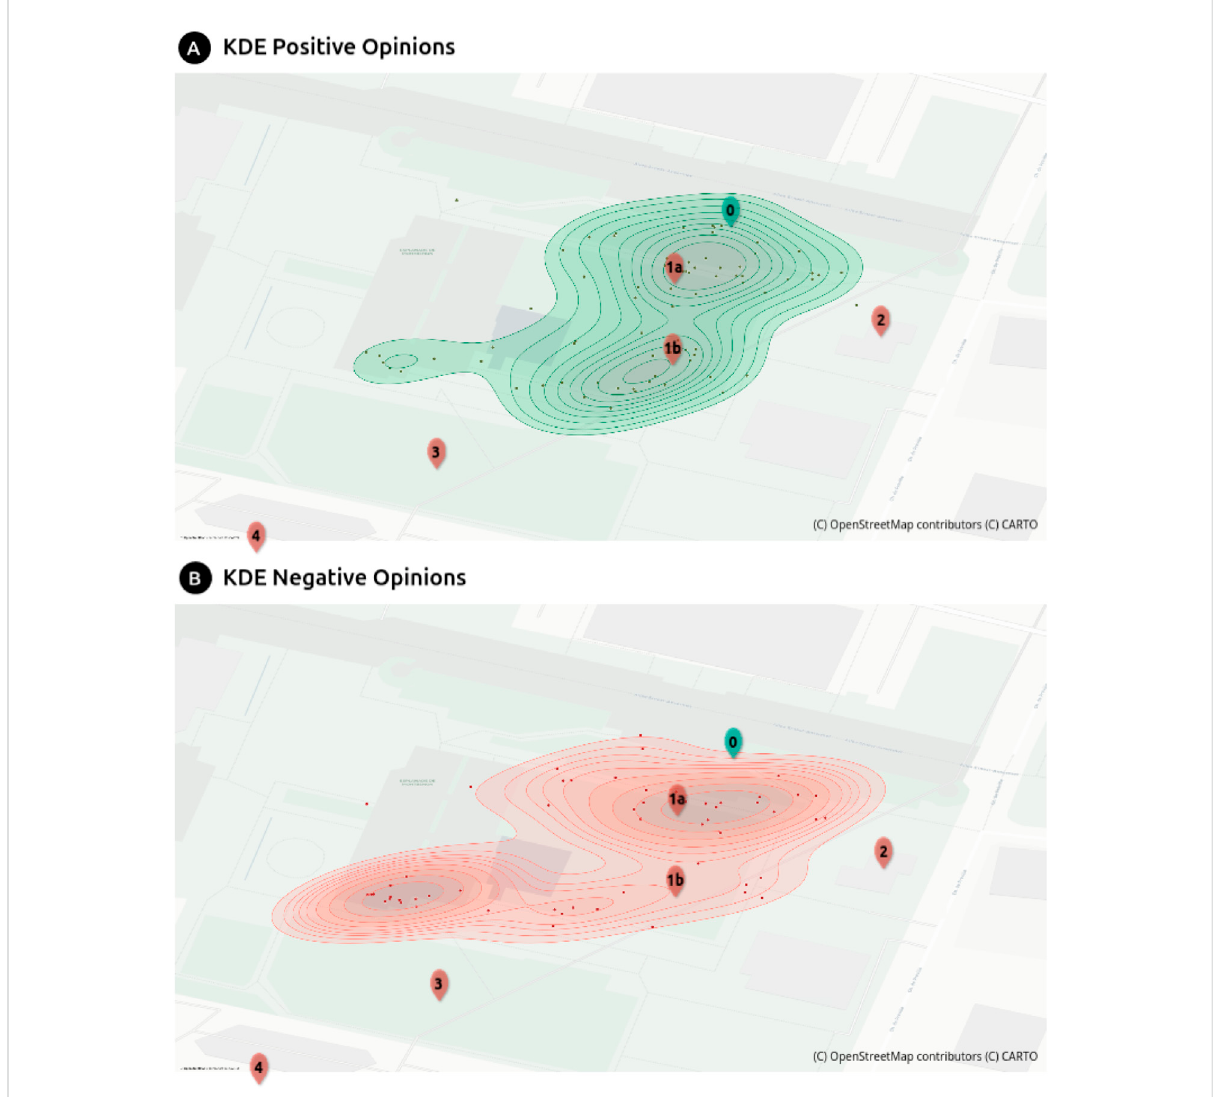
FIGURE 5 Kernel Density Estimator of the positive (A) and negative (B) contributions recorded by the participants. Points 1a, 1b, 2, 3, and 4 represent the objects of the project described in Figure 3.